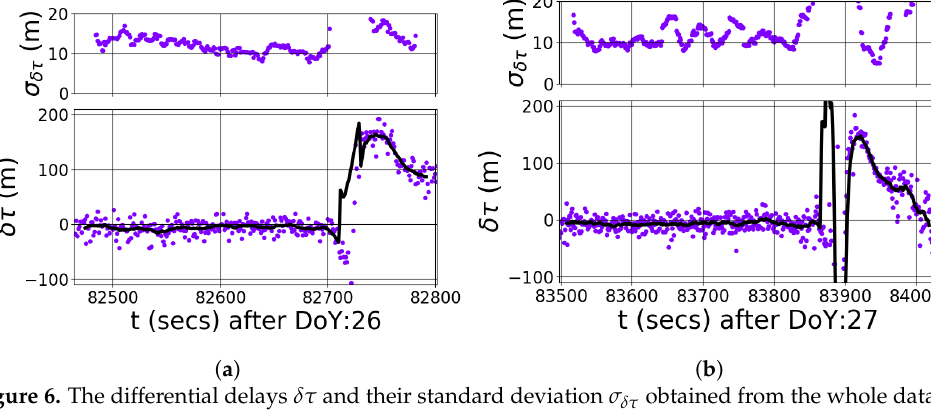
Figure 6. The differential delays δτ and their standard deviation σ δτ obtained from the whole data set, after correcting for the trend derived from the sea waveforms. Superimposed to the values δτ sea we include a running mean used to derive σ δτ . ( a ) 26 January 2015. ( b ) 27 January 2015.